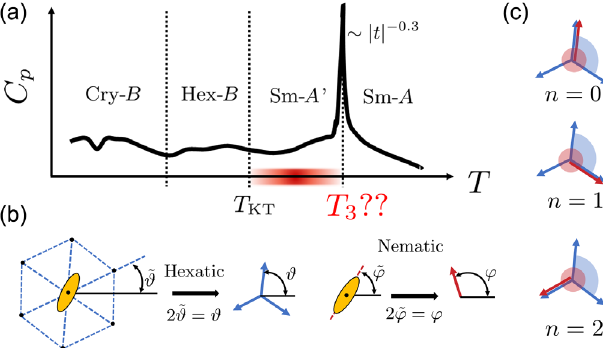
FIG. 2. (a) Schematic of the specific heat curve obtained by Chou et al. [32] upon melting of 54COOBC. (b) The hexatic bond-orientational ϑ and molecular nematic φ degrees of freedom in the liquid-crystal film and their representations in the gener- alized XY model of Eq. (2.1). The relative orientation of neighboring nematic molecules is an open question, and we therefore do not represent it here. (c) Three relative configurations of ς ¼ 2 π n= 3 ¼ ϑ − φ [as presented in Eq. (2.2)] for the angular variables in Eq. (2.1). Shaded areas represent the domain of their respective